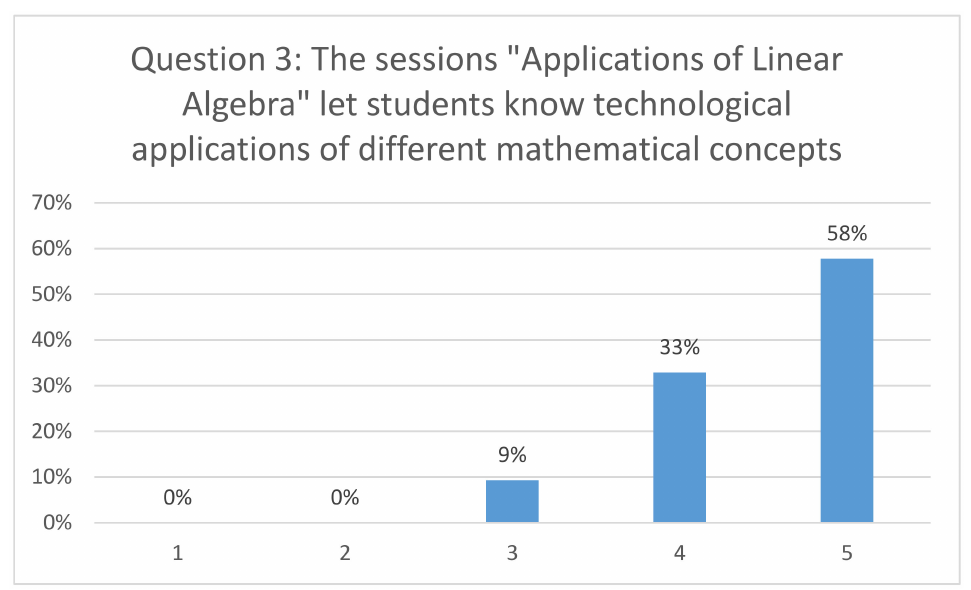
Figure 9. Answers to question 3: the sessions “Applications of Linear Algebra” let students know technological applications of different mathematical